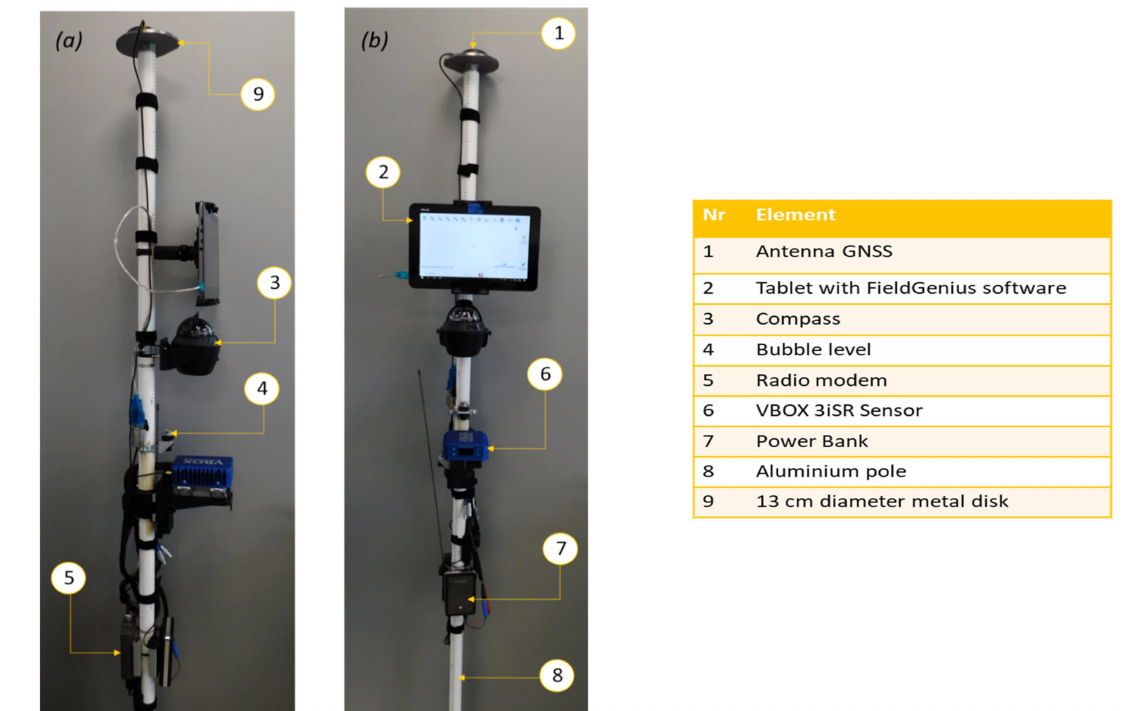
Figure 8. Photos of the stake-out geolocation device with a side view ( a ) and front view ( b ).